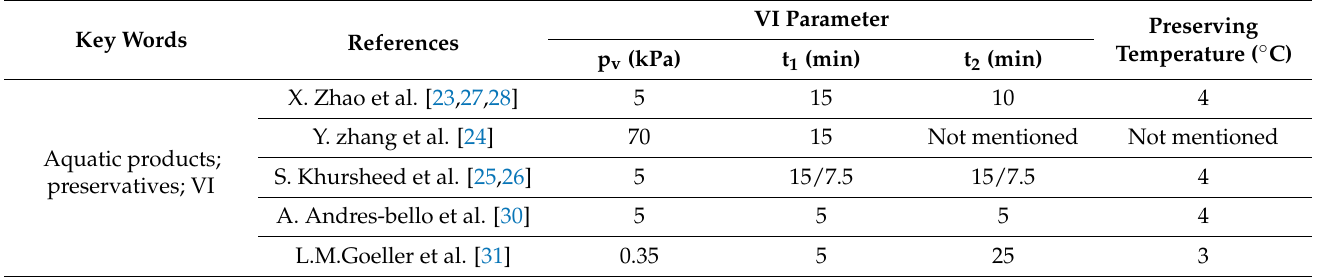
Table 1. References for studying aquatic products and meat using VI technology involving parameters of p v , t 1 , and t 2